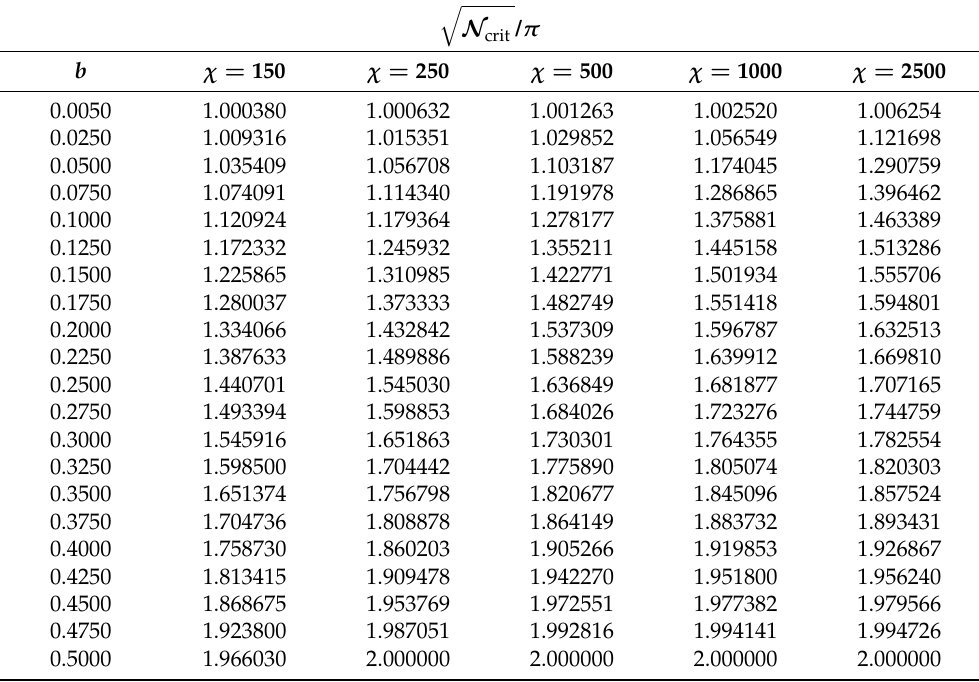
Table 8. The critical forces of PssP beams if χ = 150, . . .